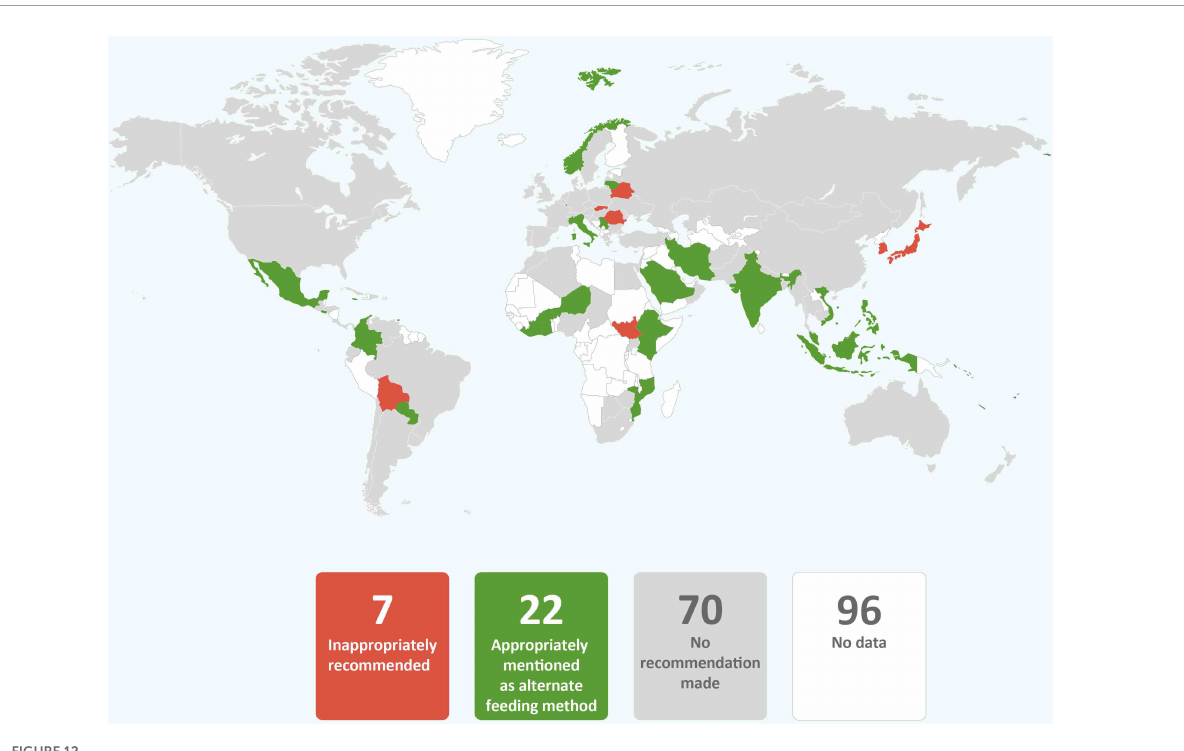
FIGURE12 Global distribution of recommendations to provide breastmilk substitutes to infants of mothers with COVID-19 only where breastfeeding or expressed breastmilk is not available (data from 101 countries).